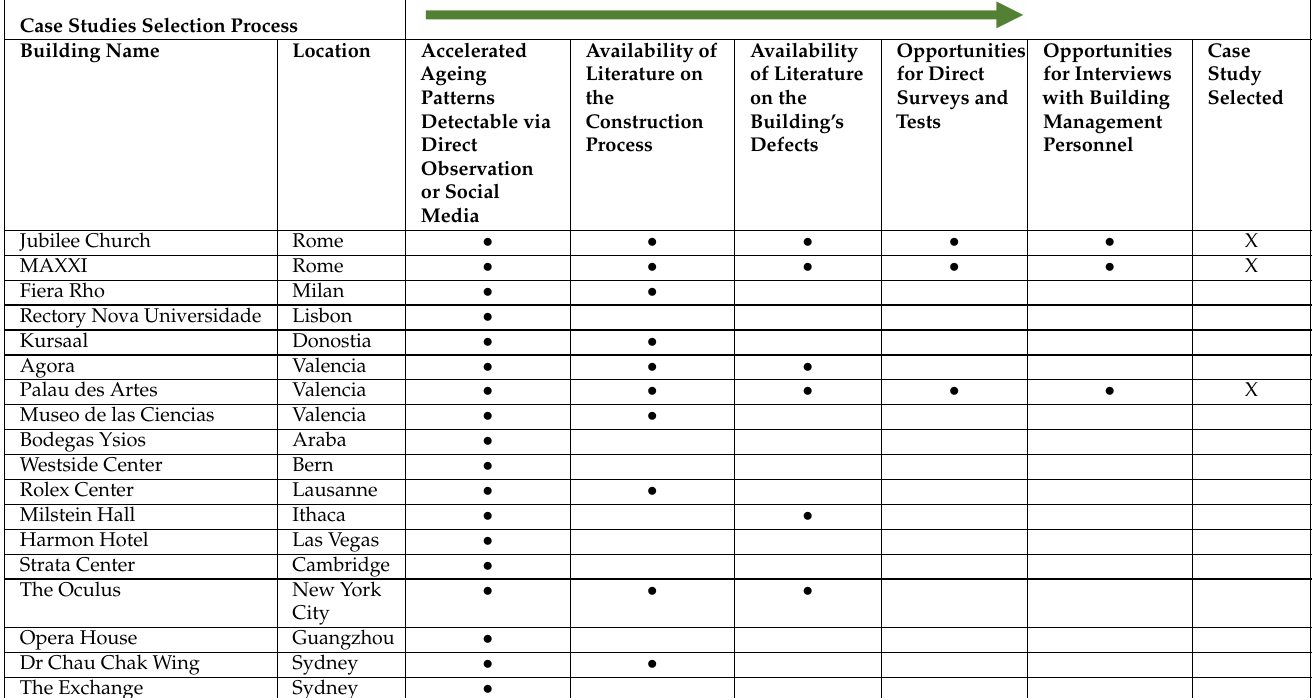
Table 1. Criteria and process for case studies